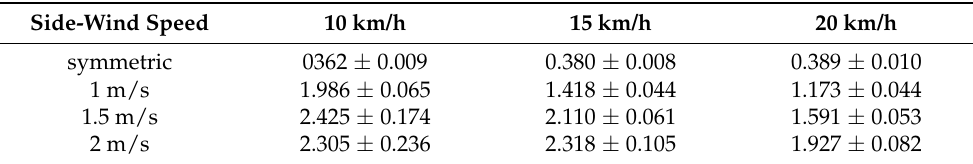
Table 5. Drag coefficients at different side-wind and cruising speed